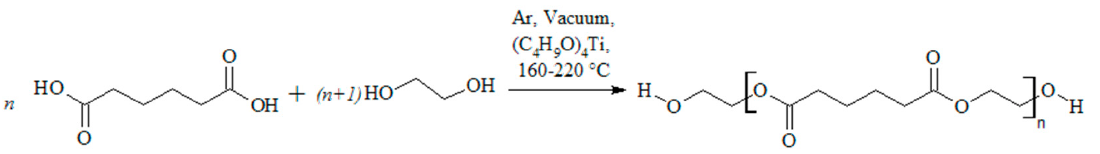
Figure 1. Synthesis of oligoethylene glycol adipinates. For the synthesis, a glass laboratory reactor equipped with a paddle stirrer, column, capillary for inert gas supply, and temperature sensor was used. In Table 1 the amounts of adipic acid and ethylene glycol loaded into the reactor are